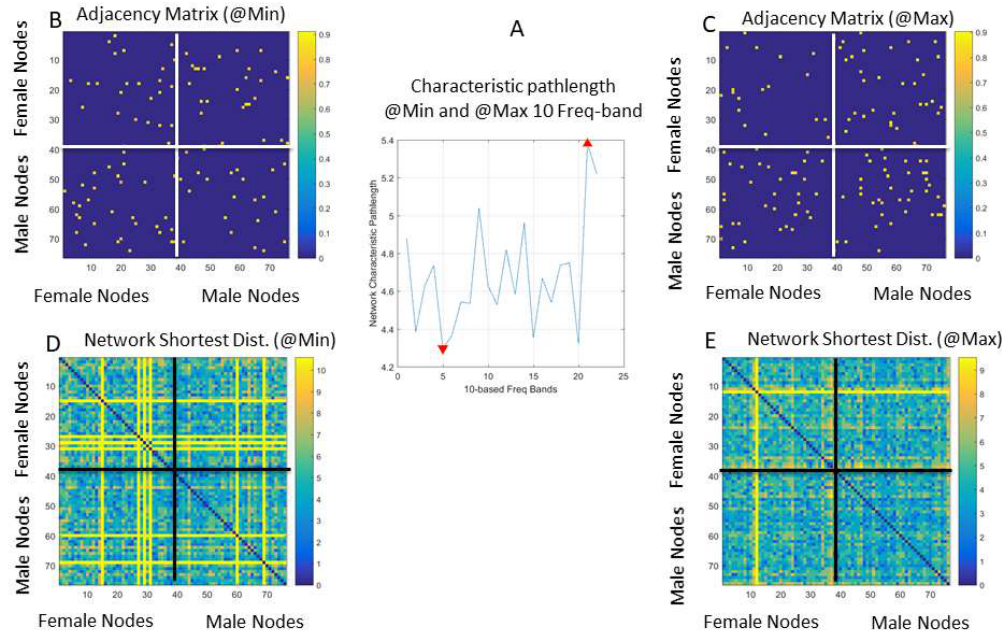
Figure 13. Network’s self-emerging connectivity patterns for different 10-based frequency bands uncover critical network states. ( A ) The characteristic pathlength of the network measuring the average shortest distance path profiled for different frequency bands. ( B ) Adjacency matrix denoting the weighted directed graph used to build the network states for the minimum and maximum characteristic pathlength revealing the frequency band for which they occur. ( C ) The network pairwise shortest distance paths when the characteristic pathlength is at its minimum value (which happens to occur at 50 Hz). ( D ) The network’s pairwise shortest-distance-path state when the characteristic pathlength is at its minimum value (occurring at 50 Hz). ( E ) The network’s pairwise shortest-distance-path state when the characteristic pathlength is at its maximum value (occurring at 210 Hz).